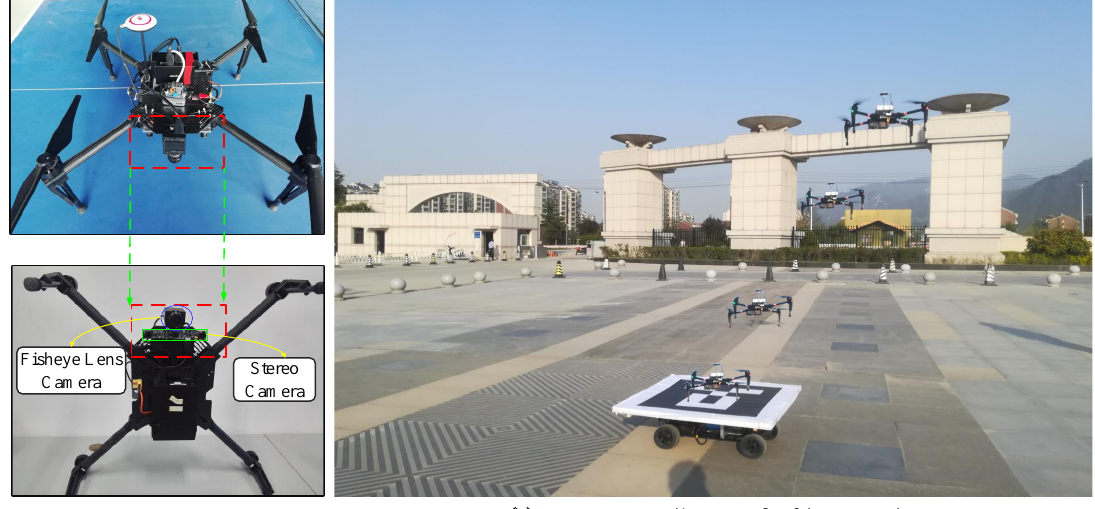
Figure 1. UAV autonomous landing system based on a hybrid camera array. ( a ) Hybrid camera array, including a fisheye lens camera and a stereo camera; ( b ) An autonomous landing example using the proposed